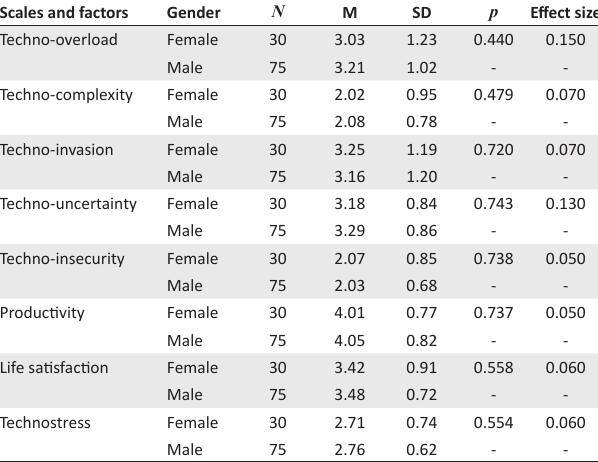
TABLE 4: Comparison between male and female respondents.